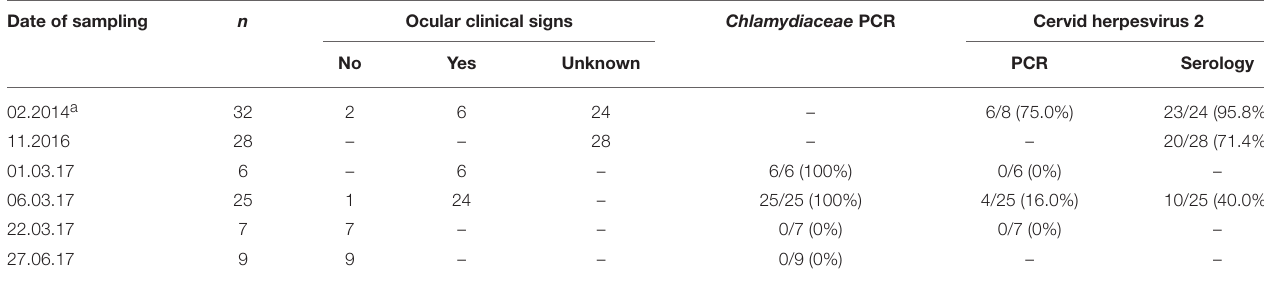
TABLE 1 | Semi-domesticated reindeer investigated during the 2014 and 2016/2017 infectious keratoconjunctivitis outbreaks in Östra